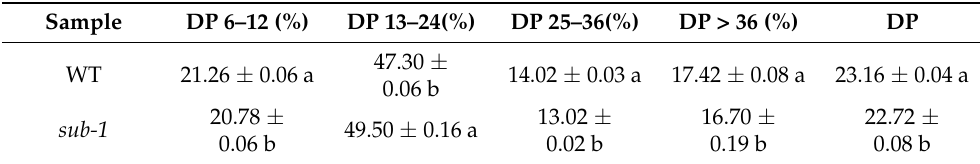
Figure 2. Chain length distributions of amylopectin in the wild type ( a ) and sub-1 mutant ( b ). Table 2. Chain length distributions of the amylopectin obtained from HPAEC-PAD. Sample